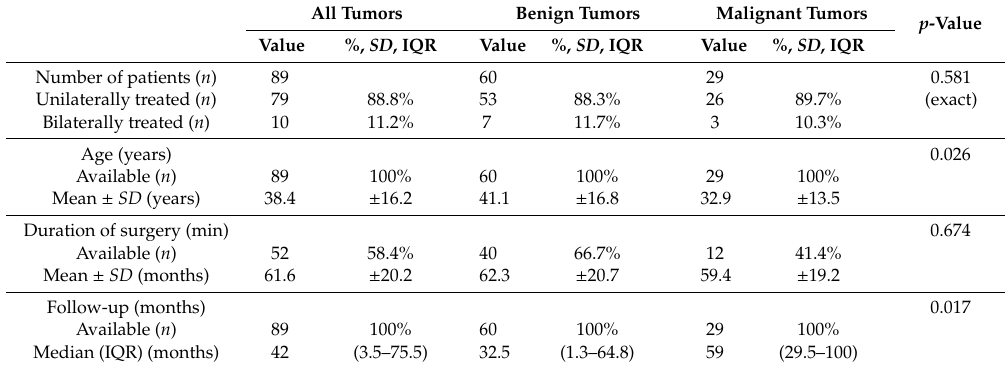
Table 1. Summary of baseline characteristics at the patient level.